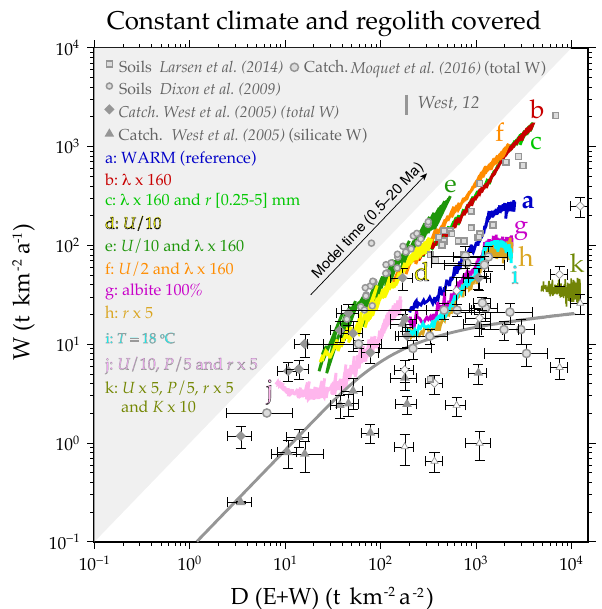
Figure 4. Comparison of the total denudation rate (physical ero- sion + weathering) in CIDRE vs. the weathering rate with data and the model of West (2012). Grey symbols correspond to cratons and submontane domains covered by regolith (West et al., 2005). White symbols correspond to the bedrock-dominated alpine do- mains of West et al. (2005). The data of Moquet et al. (2016) are in the Andes and Amazon basin. Data from Dixon et al. (2009b) are from Sierra Nevada, California. Data from Larsen et al. (2014) are from New Zealand. Data from Dixon et al. (2009) and Larsen et al. (2014) correspond to local soil production rates in rapidly eroding settings. They thus represent some maximum weathering rates, to which it is useful to compare our model results. Note that CIDRE results correspond to silicate weathering rates, not total weathering rate. We show both sets of data to emphasise that the modelled silicate weathering rate is probably overestimated but re- mains in the range of measured total weathering rates. The CIDRE simulations correspond to regolith-covered mountains ( N reg > 1). In order to convert the CIDRE weathering and erosion rates into tkm − 2 a − 1 , a density of 2.6tm − 3 (albite) was used. There is no lateral erosion ( α = 0). (a) Reference WARM model with uplift U = 1mma − 1 ; precipitation P = 1ma − 1 ; temperature T = 25 ◦ C; clast radius r = 1mm; albite (55%), quartz (30%), and biotite (15%); and mineral roughness λ = 1. Consequently N clast = 0 . 003 and N reg = 1.7. (b) N clast = 0 . 45 and N reg = 1.7. (c) Random ini- tial distribution of r between 0.25 and 5mm following a power law with exponent − 3 and a mean of 1mm. N clast = 0.45 and N reg = 1.7. (d) N clast = 0.09 and N reg = 17. (e) N clast = 14 and N reg = 17. (f) N clast = 1.5 and N reg = 3.4. (g) N clast = 0.003 and N reg = 1.7. (h) N clast = 0.0009 and N reg = 1.1. (i) N clast = 0.0006 and N reg = 1 . 7. (j) N clast = 0.002 and N reg = 3 . 4. (k) N clast = 0.00001 and N reg = 1 . 1. The weathering rate is smaller for pure albite (g) than for a granitoid composition (a) because the reactive specific surface of the albite minerals (clast surface divided by mineral vol- ume) is smaller in (g) than in